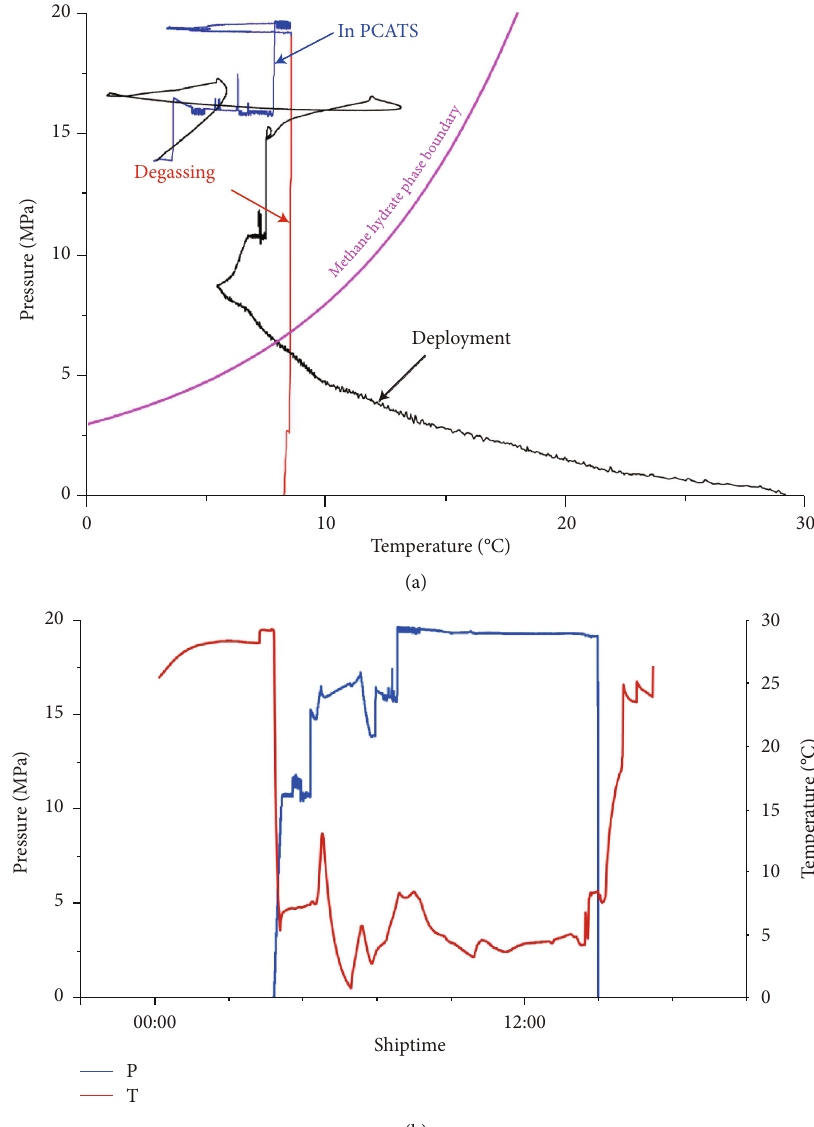
Figure 2: (a) comparison of the pressure and temperature conditions with the gas hydrate phase diagram. Pink line: phase boundary of methane hydrates within a 3.5wt% NaCl solution [8]. Black line: deployment of the pressure coring system, including from the vessel to the sea fl oor, within the borehole, from the sea fl oor back to the vessel, and from the deck to the lab. Blue line: within the PCATS for the entire triaxial test. Red line: degassing of the pressure core. (b) Temperature and pressure variations of the core with